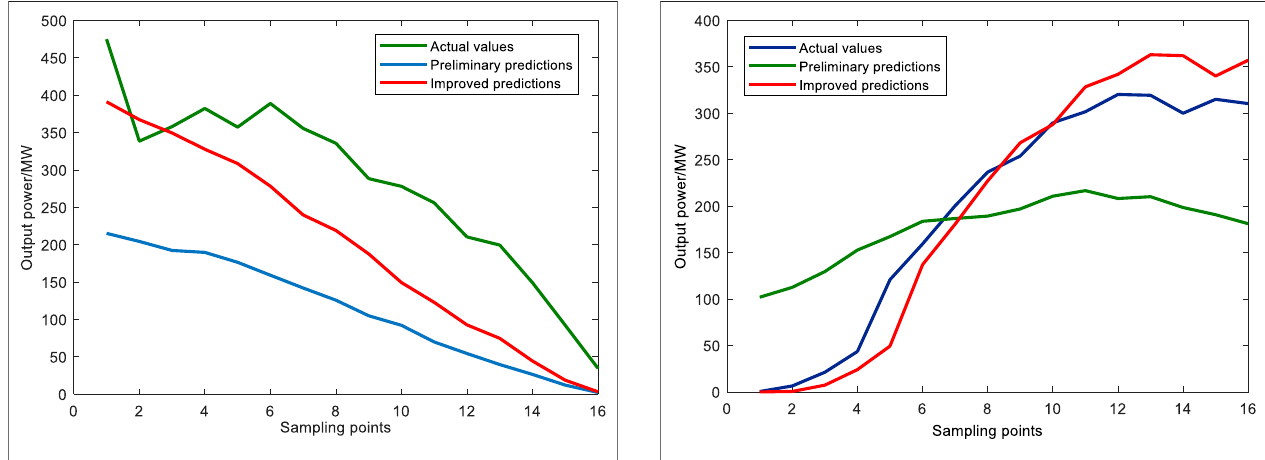
FIGURE 12 | Comparison of results before and after improvement in the afternoon phase.